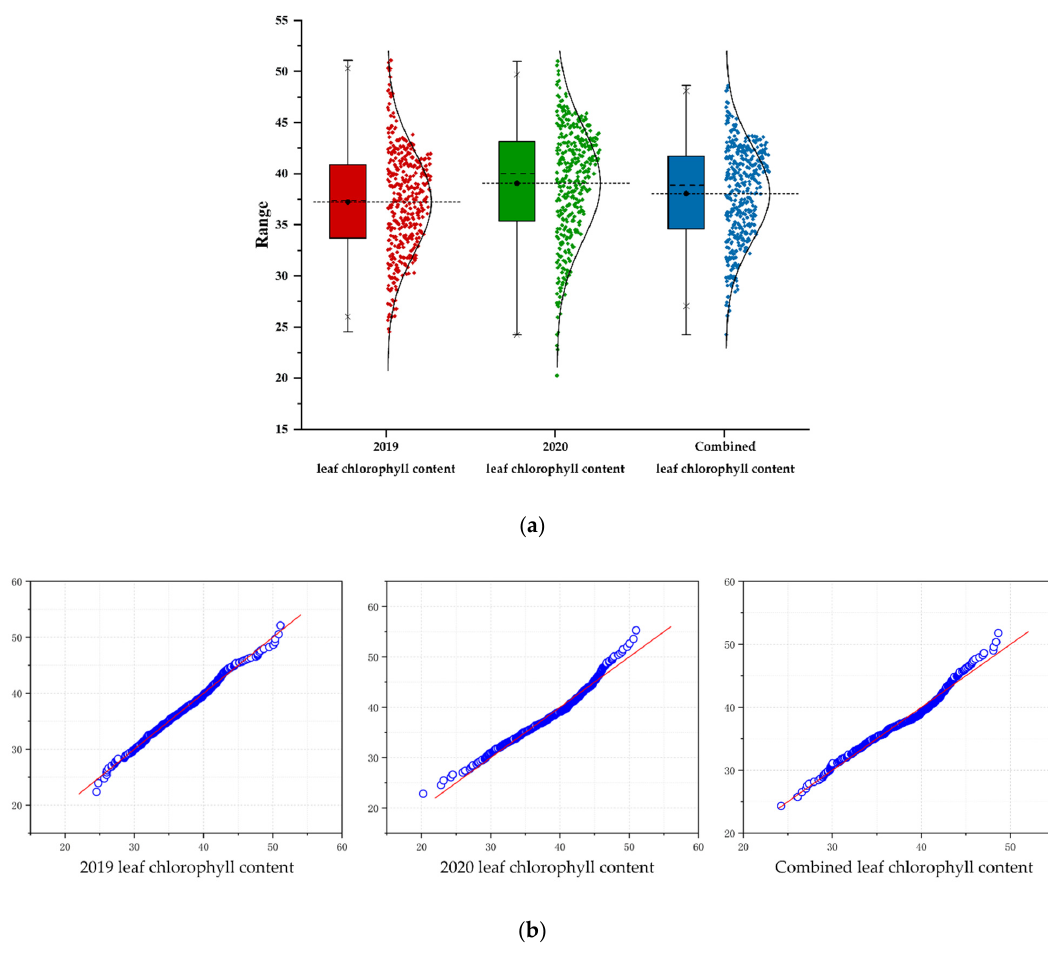
Figure 2. ( a ) Peanut leaf chlorophyll content histogram using the normal distribution test. The minimum and maximum values of leaf chlorophyll content in the 2019 season were 2453 and 5110, respectively, and those in the 2020 season were 2025 and 5100, respectively. The minimum and maximum values for the combined leaf chlorophyll content across both seasons were 2425 and 4863, respectively; ( b ) The normal distribution test showed that the scatter points of the quantile–quantile (QQ plot) graph were clustered around the fixed line for the 2019, 2020, and the combined leaf chlorophyll content ( p = 0.05).